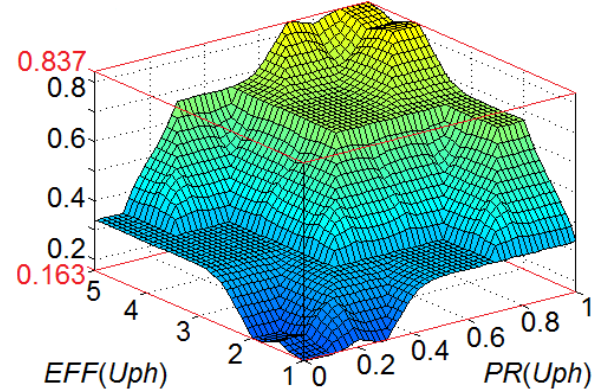
Figure 14: Surface solutions – centre of gravity